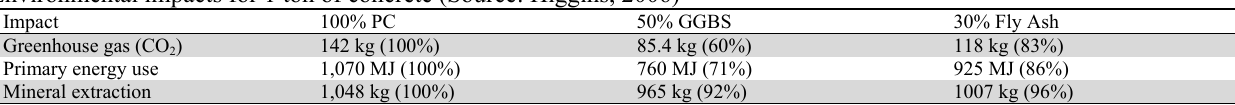
Environmental impacts for 1 ton of concrete (Source: Higgins, 2006)